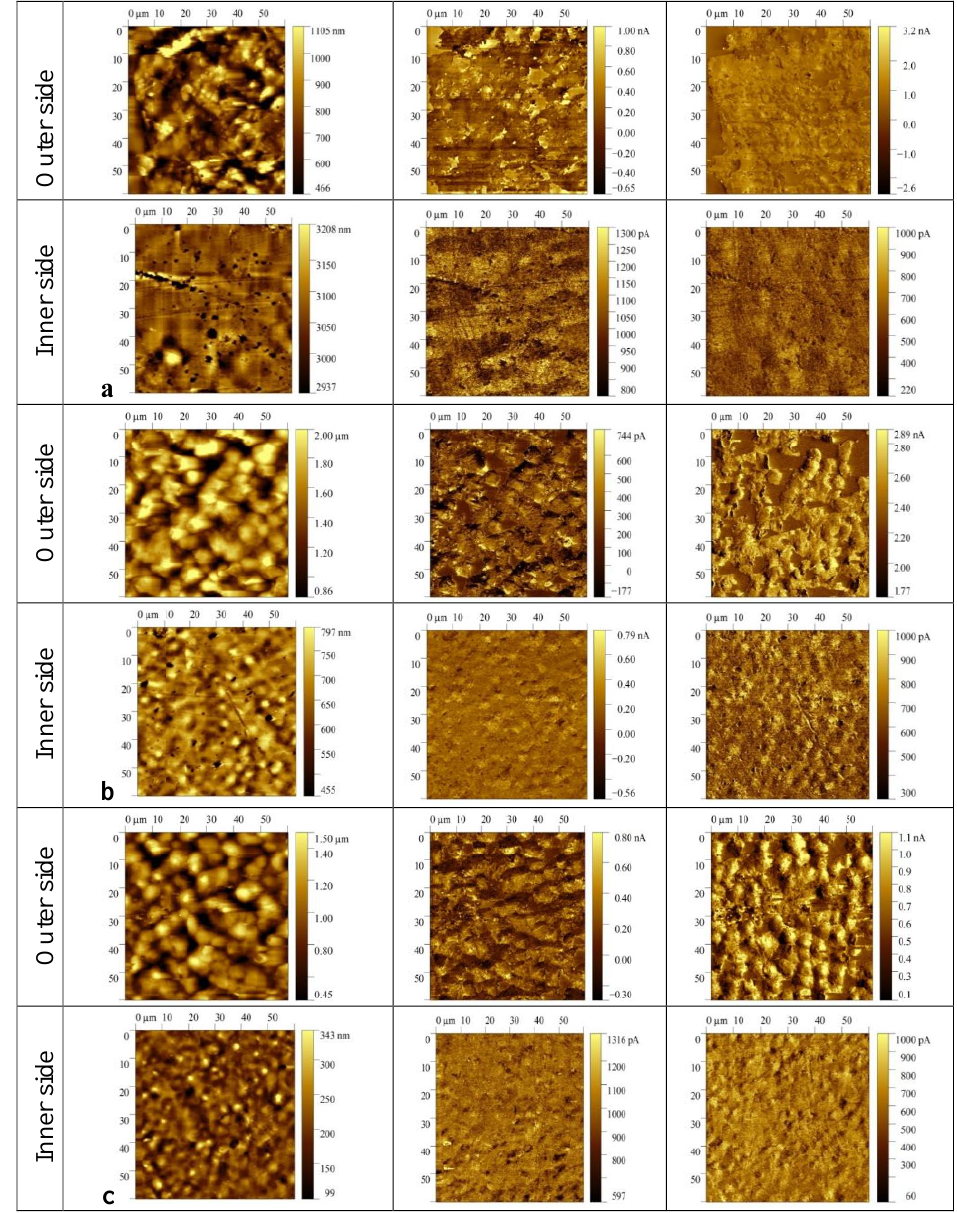
Figure 6. PFM images of the film surface topography (left), vertical (middle), and lateral (right) piezoresponse signals for P(VDF-HFP) films: ( a ) initial, ( b ) TPP-doped, ( c ) ZnTPP-doped. Table 3. RMS roughness values (nm) of the films crystallized from the acetone solutions. Sample Inner Side Outer